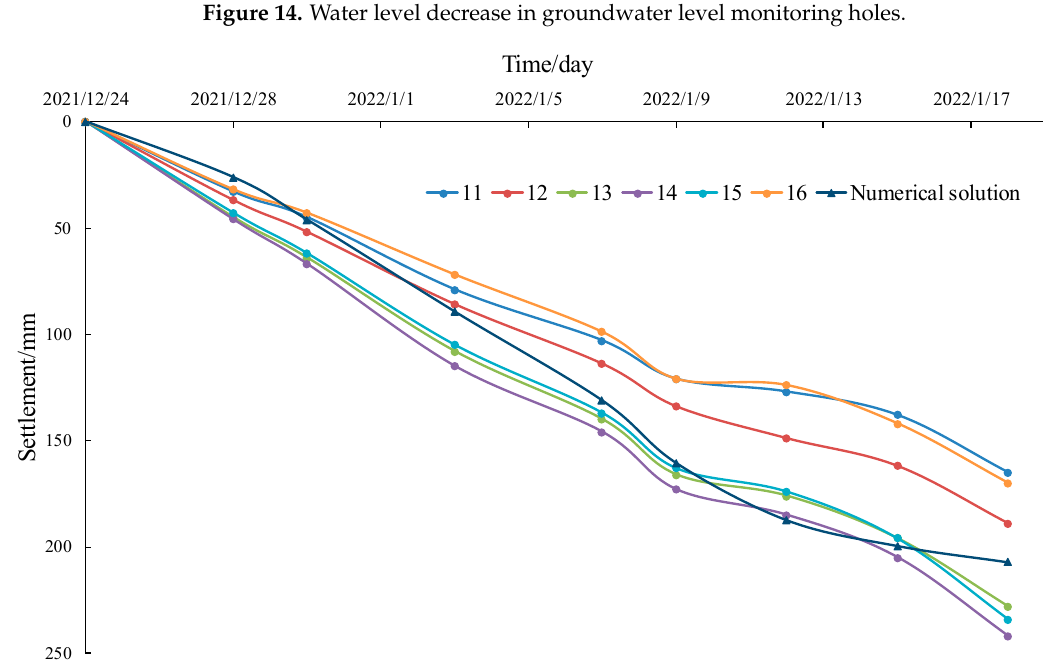
Figure 15. The surface se tt lement in the siphon drainage test area.